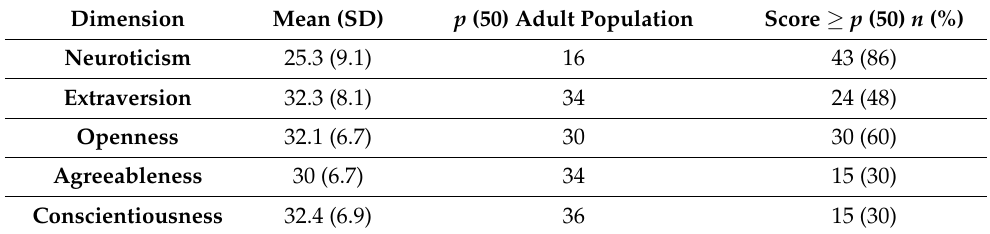
Table 2. Sample’s personality dimensions according to the NEO-FFI scale. Dimension